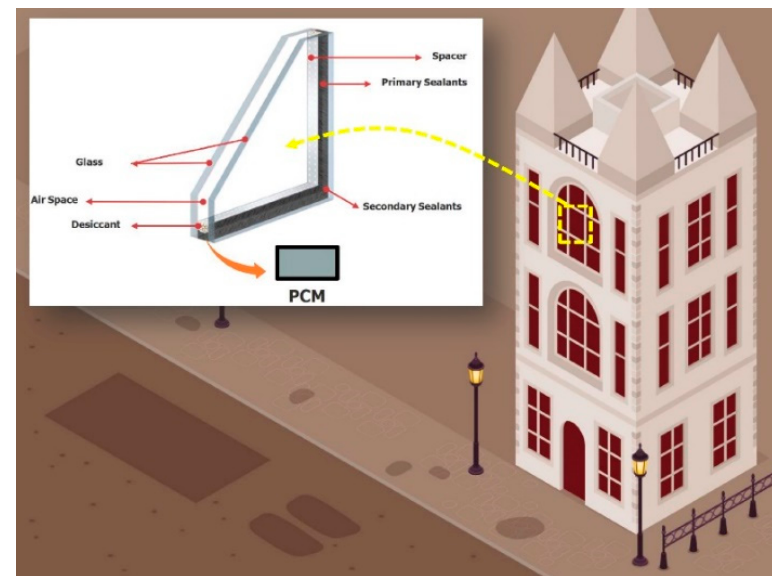
Figure 10. Schematic of fenestration system [39].